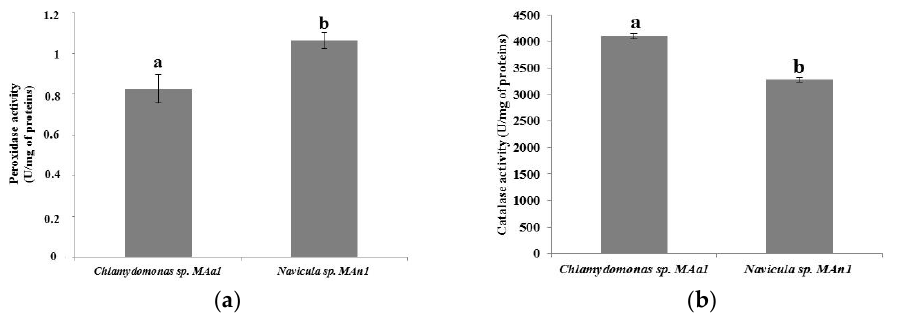
Figure 2. Enzymatic antioxidant activities of Chlamydomonas sp. MA a1 and Navicula sp. MA n1 methanol extracts. ( a ) Peroxidase activities; ( b ) catalase activities. Data show means ± SD ( n = 3). Statistical significance was determined by a Student’s t test; significant difference ( p < 0.05) is indicated by different lowercase letters.